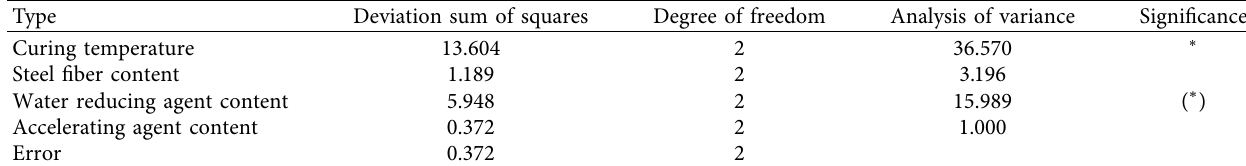
Table 9: Table of variance analysis of compressive strength of 3-day-old concrete specimen.